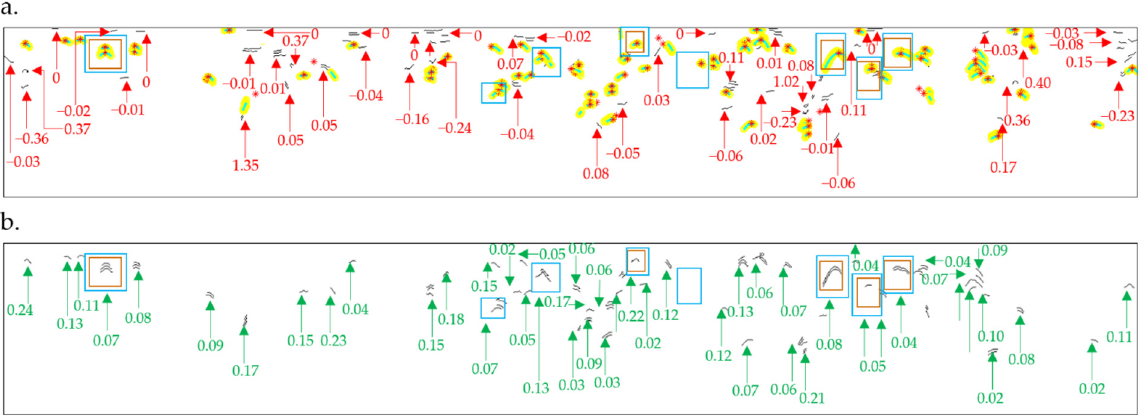
Figure 12. Results of introducing the condition for the curvature of the object: ( a ) target image before introducing the C C condition; ( b ) image after introducing the C C condition.